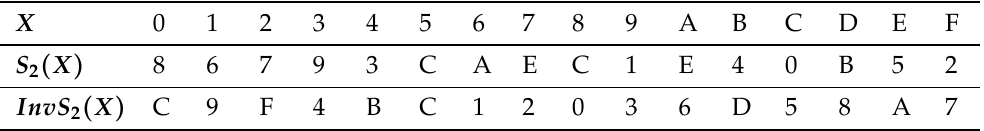
Table 3. Third S-Box of Serpent defined as S 2 ( X ) .